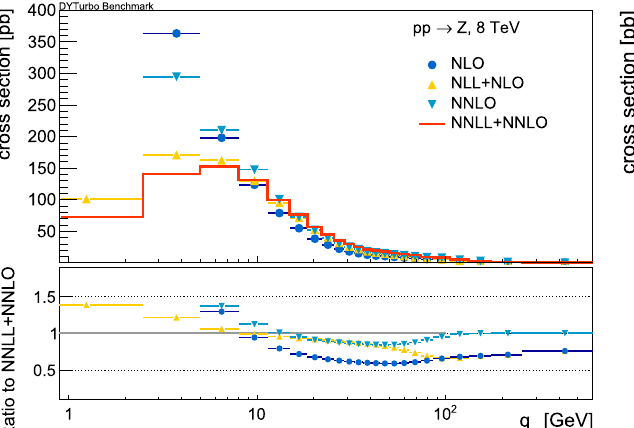
at NNLL + NNLO accuracy for the Z -boson total cross section at √ s = 8 TeV as a function of the boson transverse momentum and the separated contribution of various terms: resummed component, asymp- totic term, finite-order term, sum of asymptotic and finite-order terms